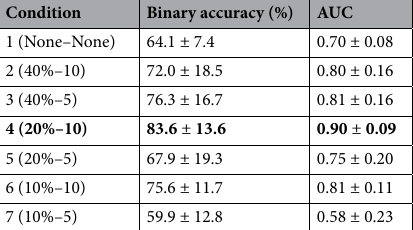
Table 3. Averaged validation results across 10 random training-validation splits using Monte-Carlo cross- validation. Optimal training parameters are in bold.